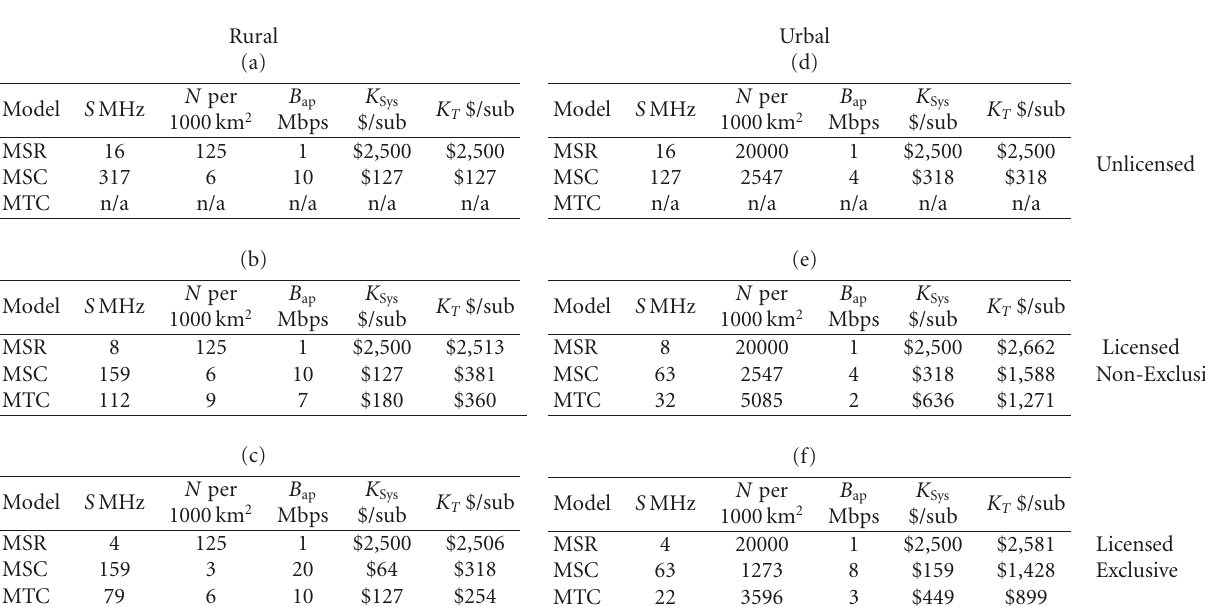
Table 1: Output results in each